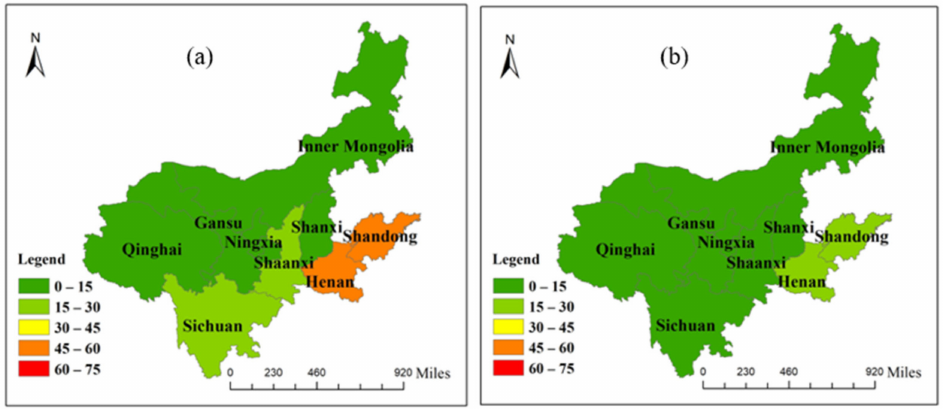
Figure 7. Virtual water inflow of each province in the Yellow River Basin: ( a ) inflow from provinces outside the Yellow River Basin; ( b ) inflow within the Yellow River